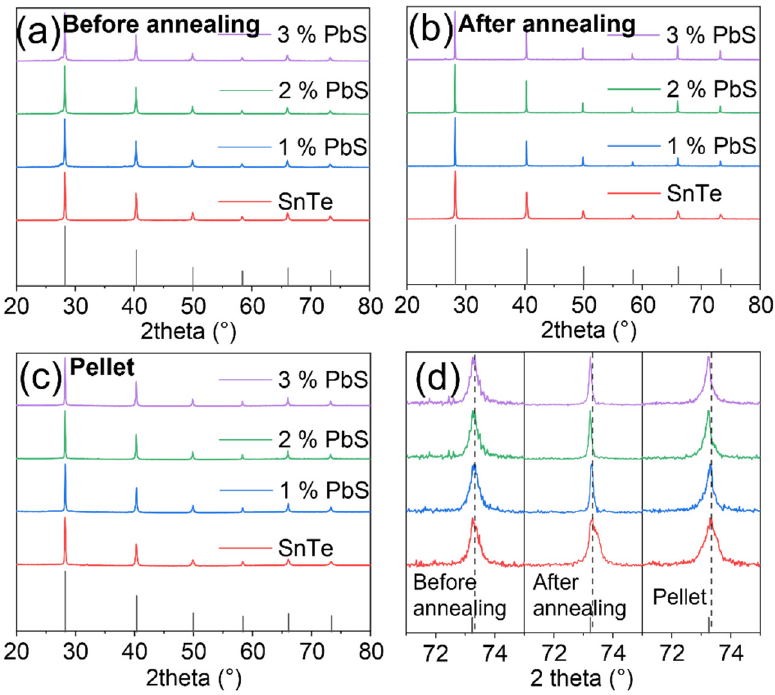
Figure 2. The XRD patterns of powders ( a ) before annealing, ( b ) after annealing, and ( c ) pellets. ( d ) Amplified XRD peak in the range of 71–75 ◦